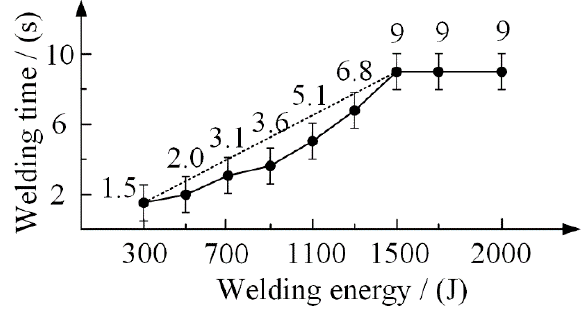
Figure 5. Relationship between welding time and welding